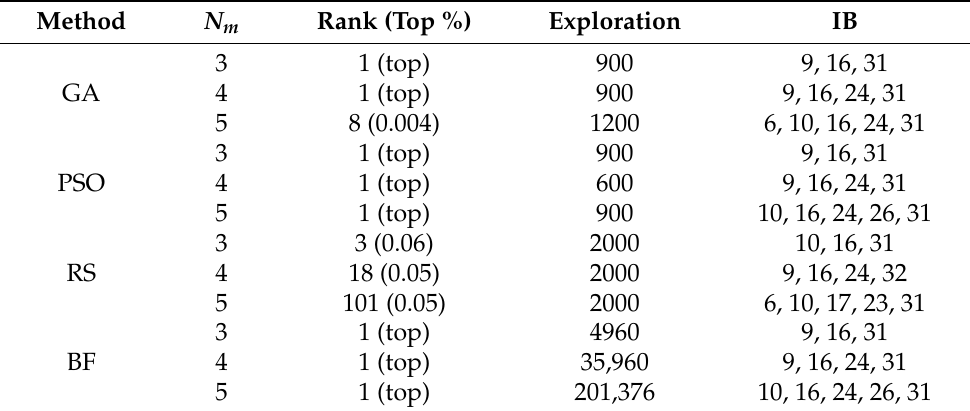
Table 3. PMU placement results—33-bus system.